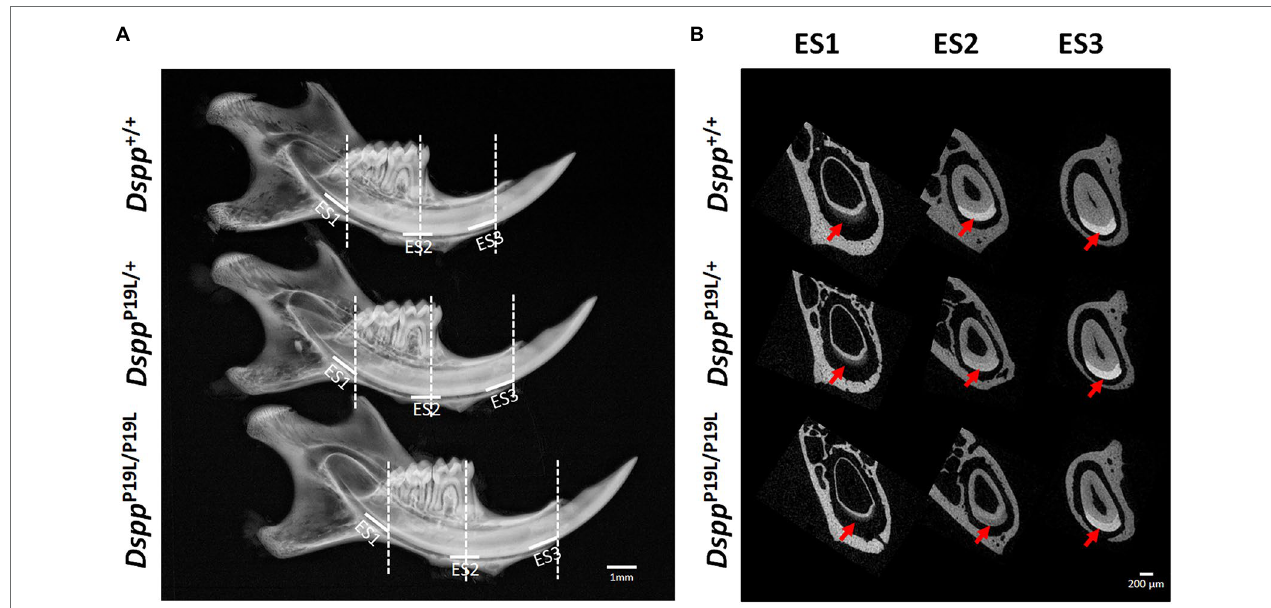
FIGURE 1 | Gross overview of the tooth phenotype of Dspp P19L/+ and Dspp P19L/P19L mice. (A) Representative plain x-ray radiographic images of the mandibles of 7-week-old wild-type Dspp +/+ , heterozygous Dspp P19L/+ and homozygous Dspp P19L/P19L mice. The white horizontal lines denote the enamel segments, ES1, ES2, and ES3, that were quantified by μ CT analyses. ES1 corresponds to the late secretory stage amelogenesis; ES2 corresponds to mid-late maturation stage amelogenesis; and ES3 is the enamel segment that has undergone extensive maturation and is about to erupt. The dashed vertical white lines in (A) mark the locations of reconstructed trans-axial μ CT images shown in (B) . Red arrows indicate the mandibular incisor enamel in the trans-axial images. Scale bars: 1 mm in A; 200 μ m in